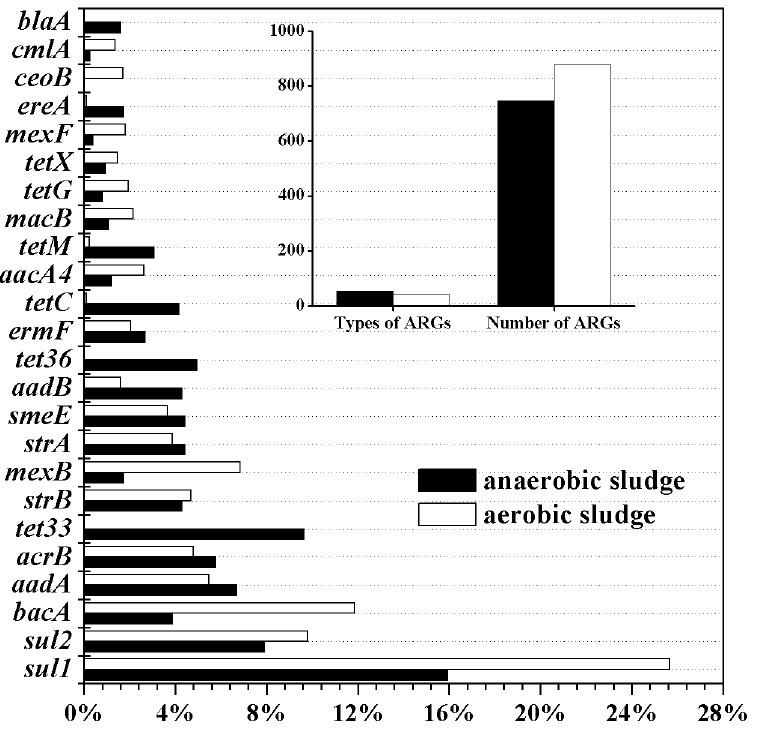
Figure 3. Types and relative abundance of antibiotic resistance genes (ARGs) in anaerobic sludge and aerobic sludge. The ARGs shown have relative abundance over 1% of the total ARGs reads in either anaerobic or aerobic